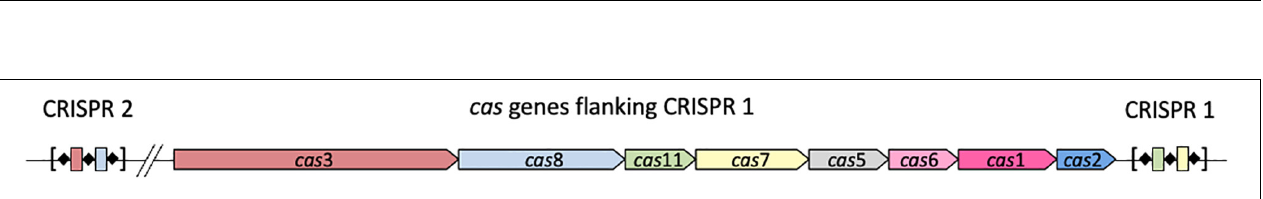
FIGURE 3 | Salmonella enterica subsp. enterica serovar Heidelberg type I-E CRISPR locus architecture. This system contains two distinct CRISPR arrays—one associated with the cas genes and one disparate locus upstream (5 (cid:48) ) from the cas genes.